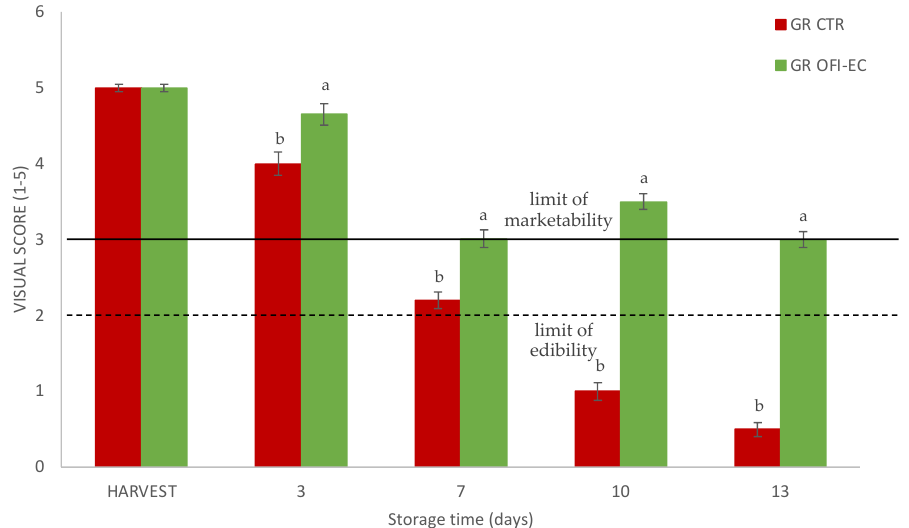
Figure 9. Visual score of minimally processed Gigante Rossa loquat fruits, untreated fruit (GR CTR), and fruits treated with mucilage (GR OFI-EC) during cold storage (13 days at 5 °C). Different low- ercase letters indicate significant differences between the treatments on each sampling date. Data are the mean ± SE (vertical bars represent standard error; n = 5 ). Data are the mean ± SE (vertical bars represent standard error; n = 5 ) with 5 = very good, 4 = good, 3 = fair (limit of marketability), 2 = poor (limit of edibility) and 1 = very poor (inedible). 4. Discussion Loquat fruits are a non-climacteric fruit, with a short postharvest life due to an in- trinsic predisposition to physical damage and microbial decay. The fruit decays quickly